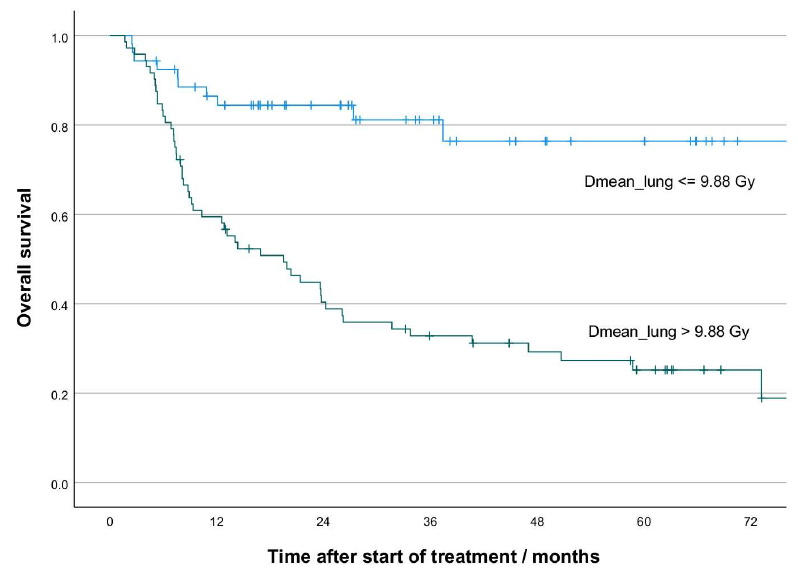
Figure 2. Exemplary Kaplan–Meier curves for overall survival based on the stratification by D mean_lung ( p < 0.001). Optimal cut-off values for respective DVH parameters have been determined based on the maximal Youden index of the receiver operating characteristics (ROC) curve of the binary endpoint.